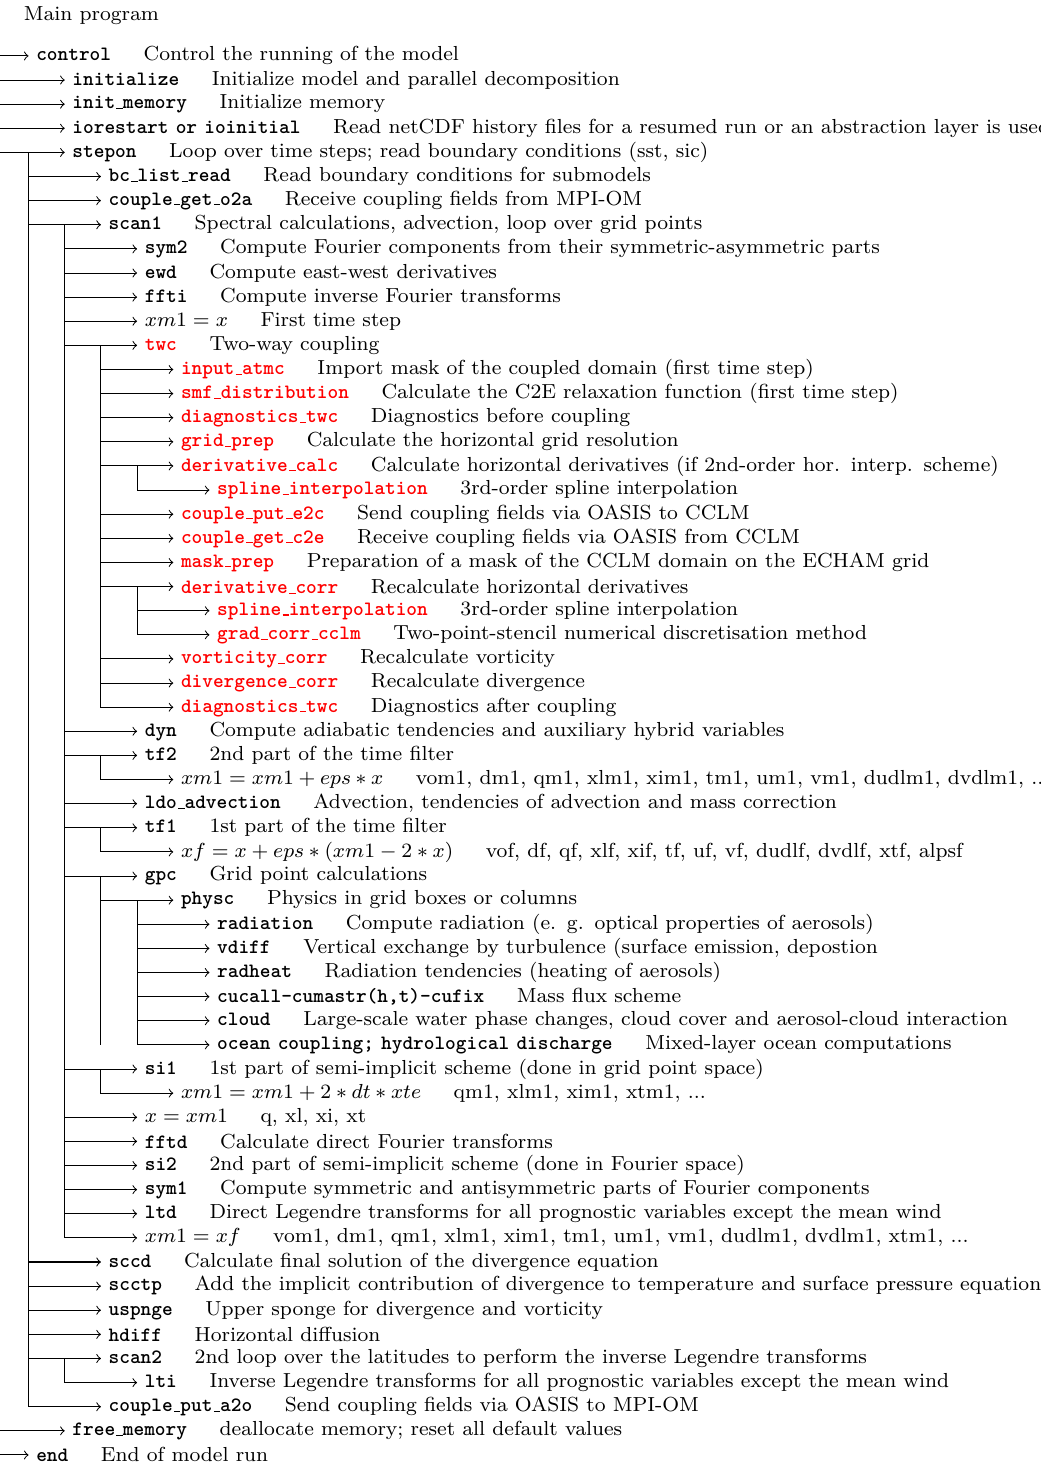
Geosci. Model Dev., 10, 1549–1586,